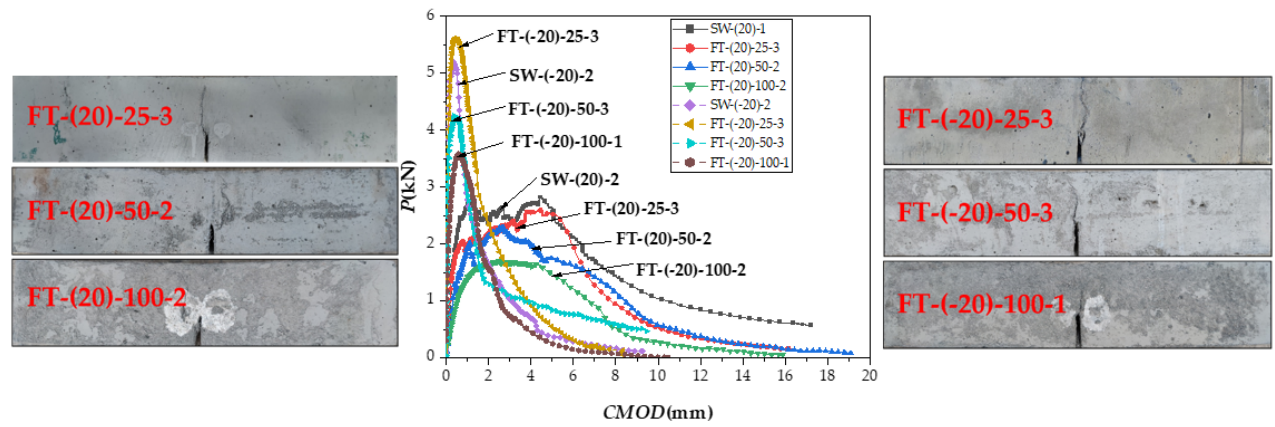
Figure 15. The failure morphology and P-CMOD curve after different freeze–thaw cycles.